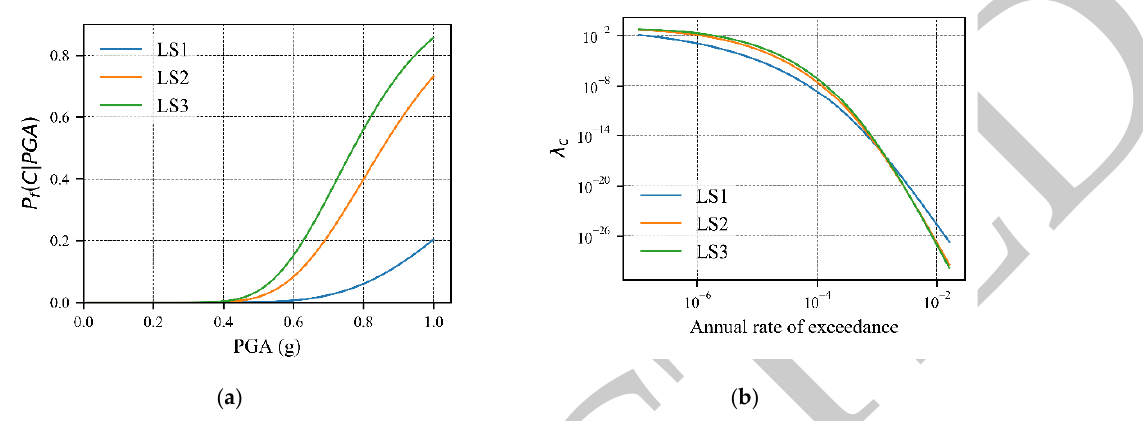
Figure 20. ( a ) Fragility analysis of structure in the site for different damage stages; ( b ) Failure risk curve.